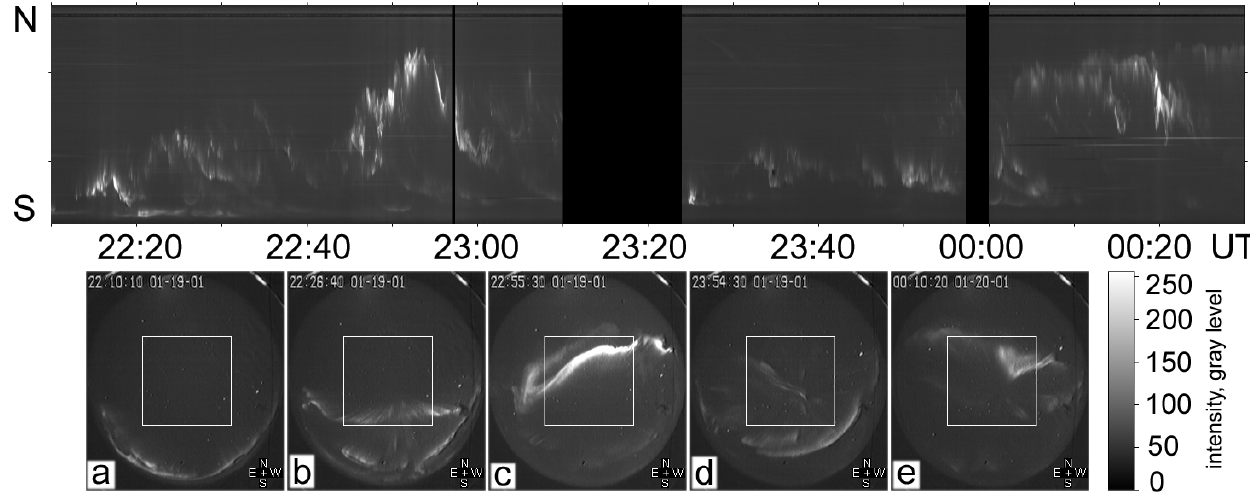
Fig. 1. Auroral structures during the event of 19–20 January 2001. Top panel: north-south keogram obtained from TV ASC images. Bottom panel: several examples of the TV ASC images. The considered part of the field of view is marked by ticks at the vertical axes of the keogram and by white frame in the